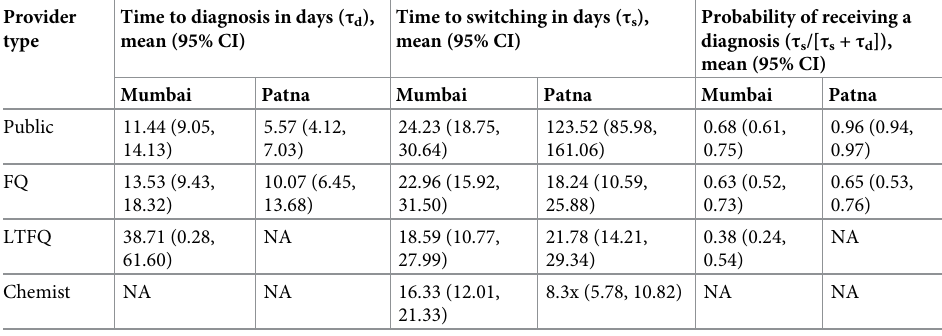
Table 6. Time to diagnosis and switching (days) and probability of receiving diagnosis.